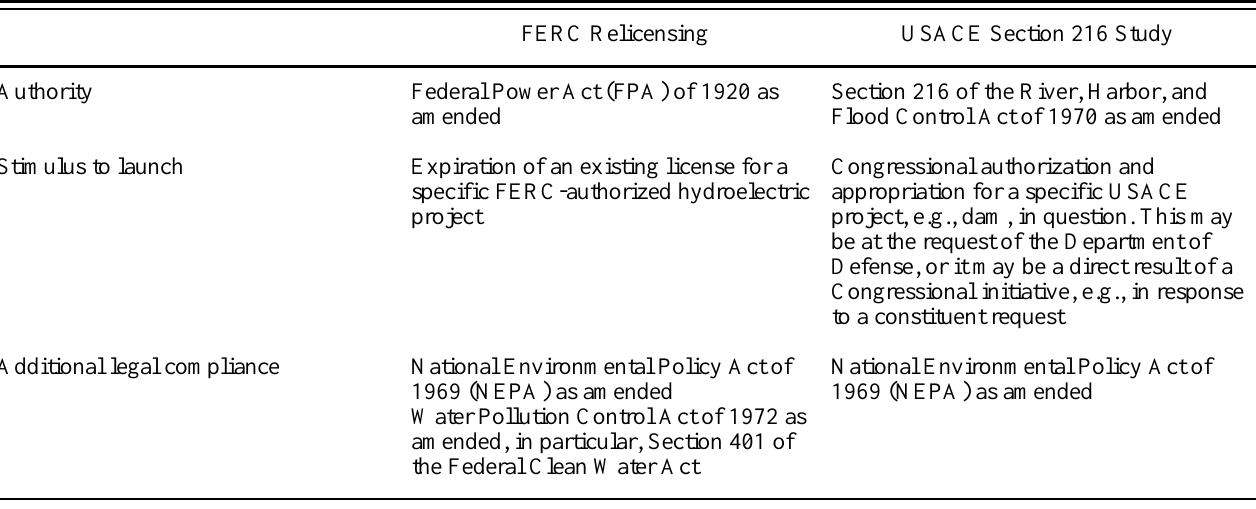
Table 1 . Contrasting the Federal Energy Regulatory Commission (FERC) relicensing and U.S. Army Corps of Engineers (USACE) Section 216